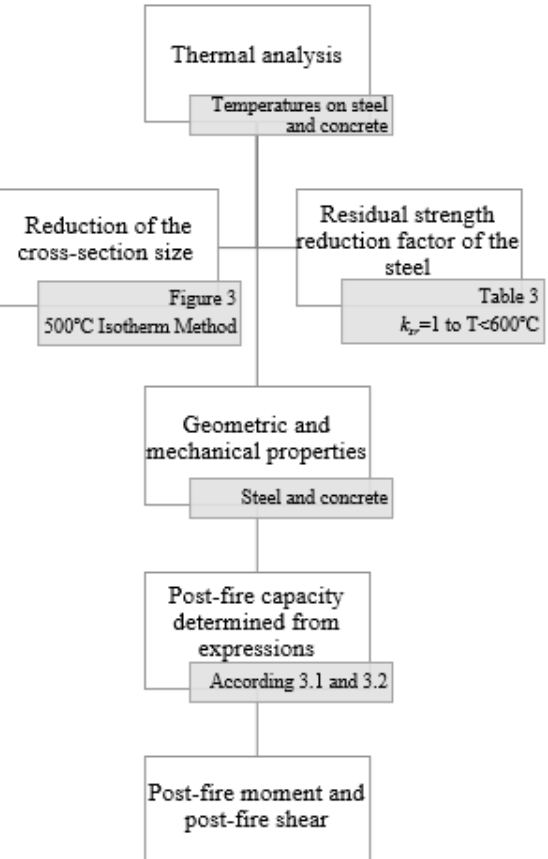
Figure 2. Procedure for determining residual